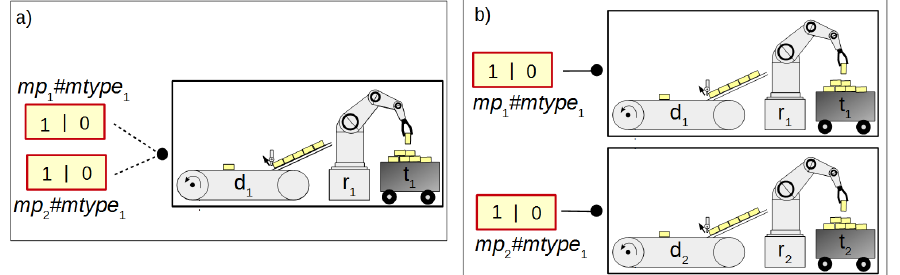
Figure 7. The application of two concepts of macroplace instances: ( a ) shared variables, ( b ) unshared